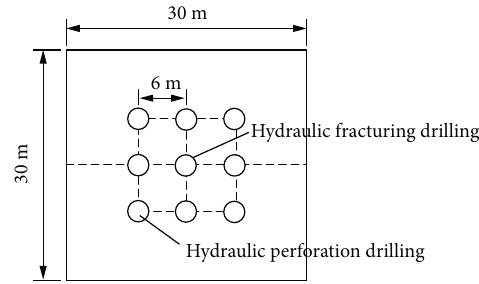
Figure 5: The drill hole layout of the numerical simulation